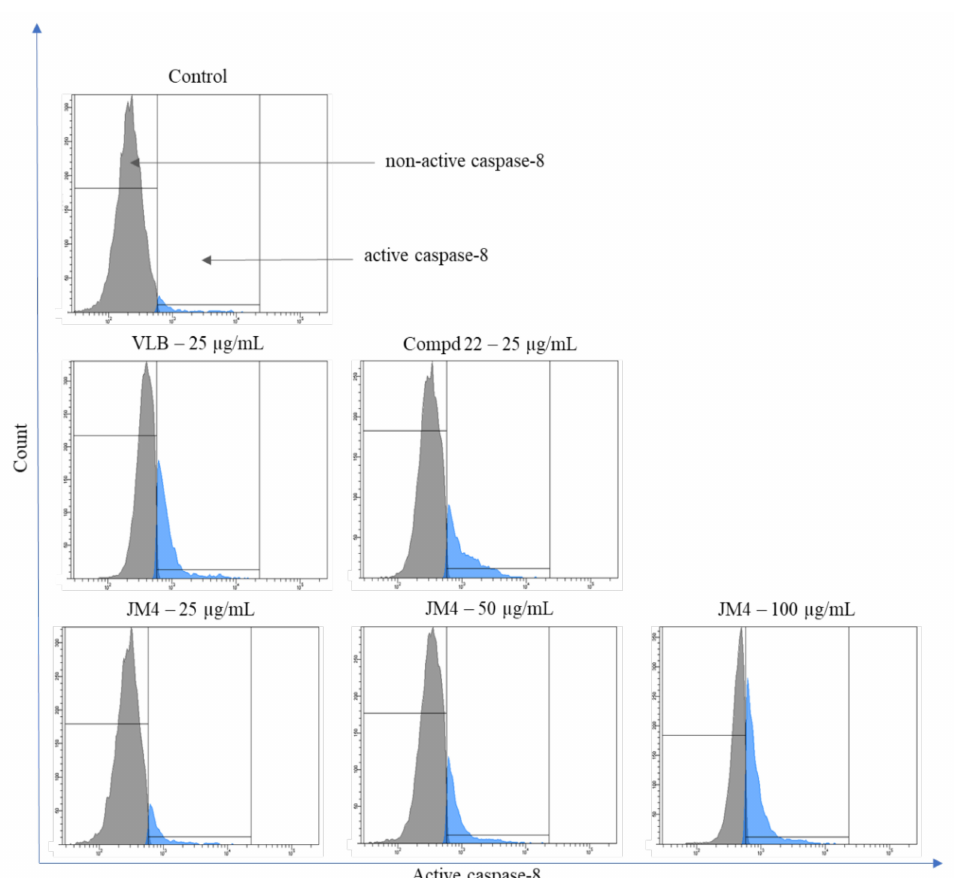
Figure 13. Flow cytometric analysis of populations C32 melanoma cells treated for 24 h with JM4 (25, 50, 100 µ g/mL), 22 (25 µ g/mL) and vinblastine sulfate (VLB) (25 µ g/mL) for active caspase-8.